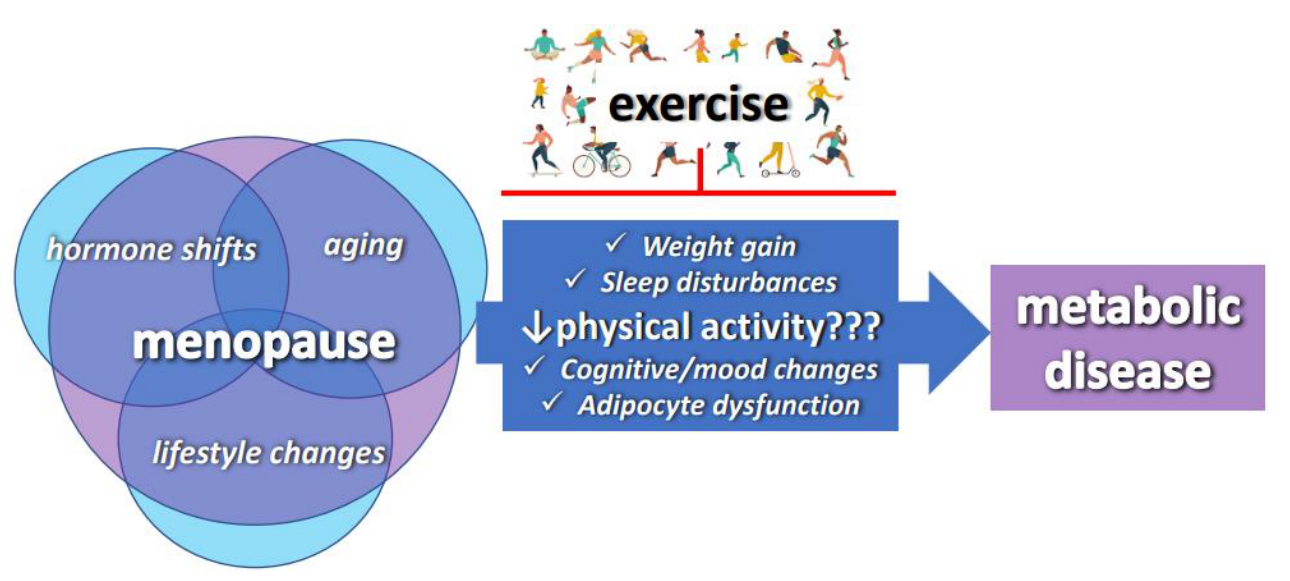
Figure 1. Schematic representation of the complex etiology of menopause-associated metabolic dysfunction and the hypothetical role of exercise in mitigating menopause-associated metabolic changes.